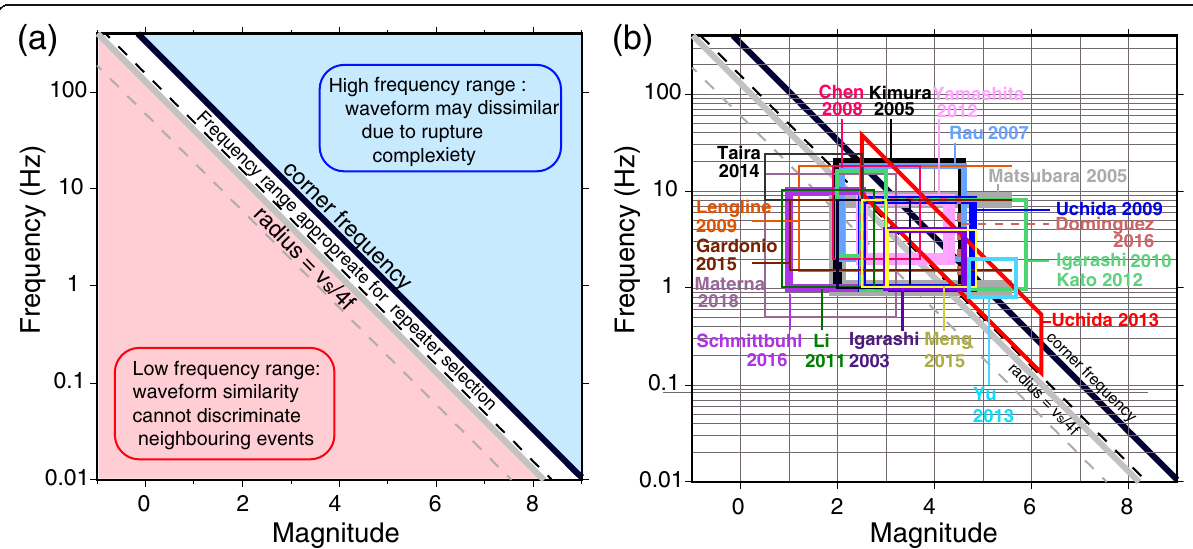
Fig. 3 a Frequency and magnitude ranges suitable for repeater detection from waveform similarity based on considerations of source size and b ranges used in previous studies. Black and gray lines respectively show the corner frequency and the condition where the resolution is equal to the fault radius for a 10 MPa stress drop. Dashed black and gray lines are the same but for a 1 MPa stress drop. Frequencies larger than the corner frequency (blue area) are considered to be inappropriate because the rupture process, including the initiation point and propagation may affect waveforms ’ shape. Having the resolution lower than the fault radius (radius ≤ v s /4 f ) (red area) is also inappropriate because non-overlapping events can also have similar waveforms. In b , frequency and magnitude ranges are plotted for the studies listed in Table 1. Note that only